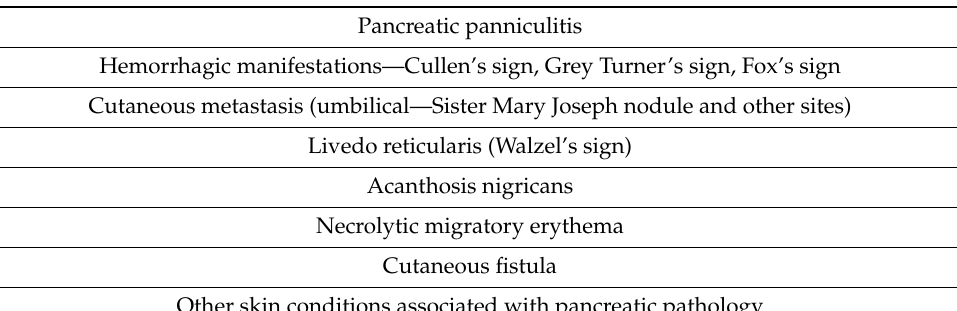
Table 1. Cutaneous manifestations in pancreatic